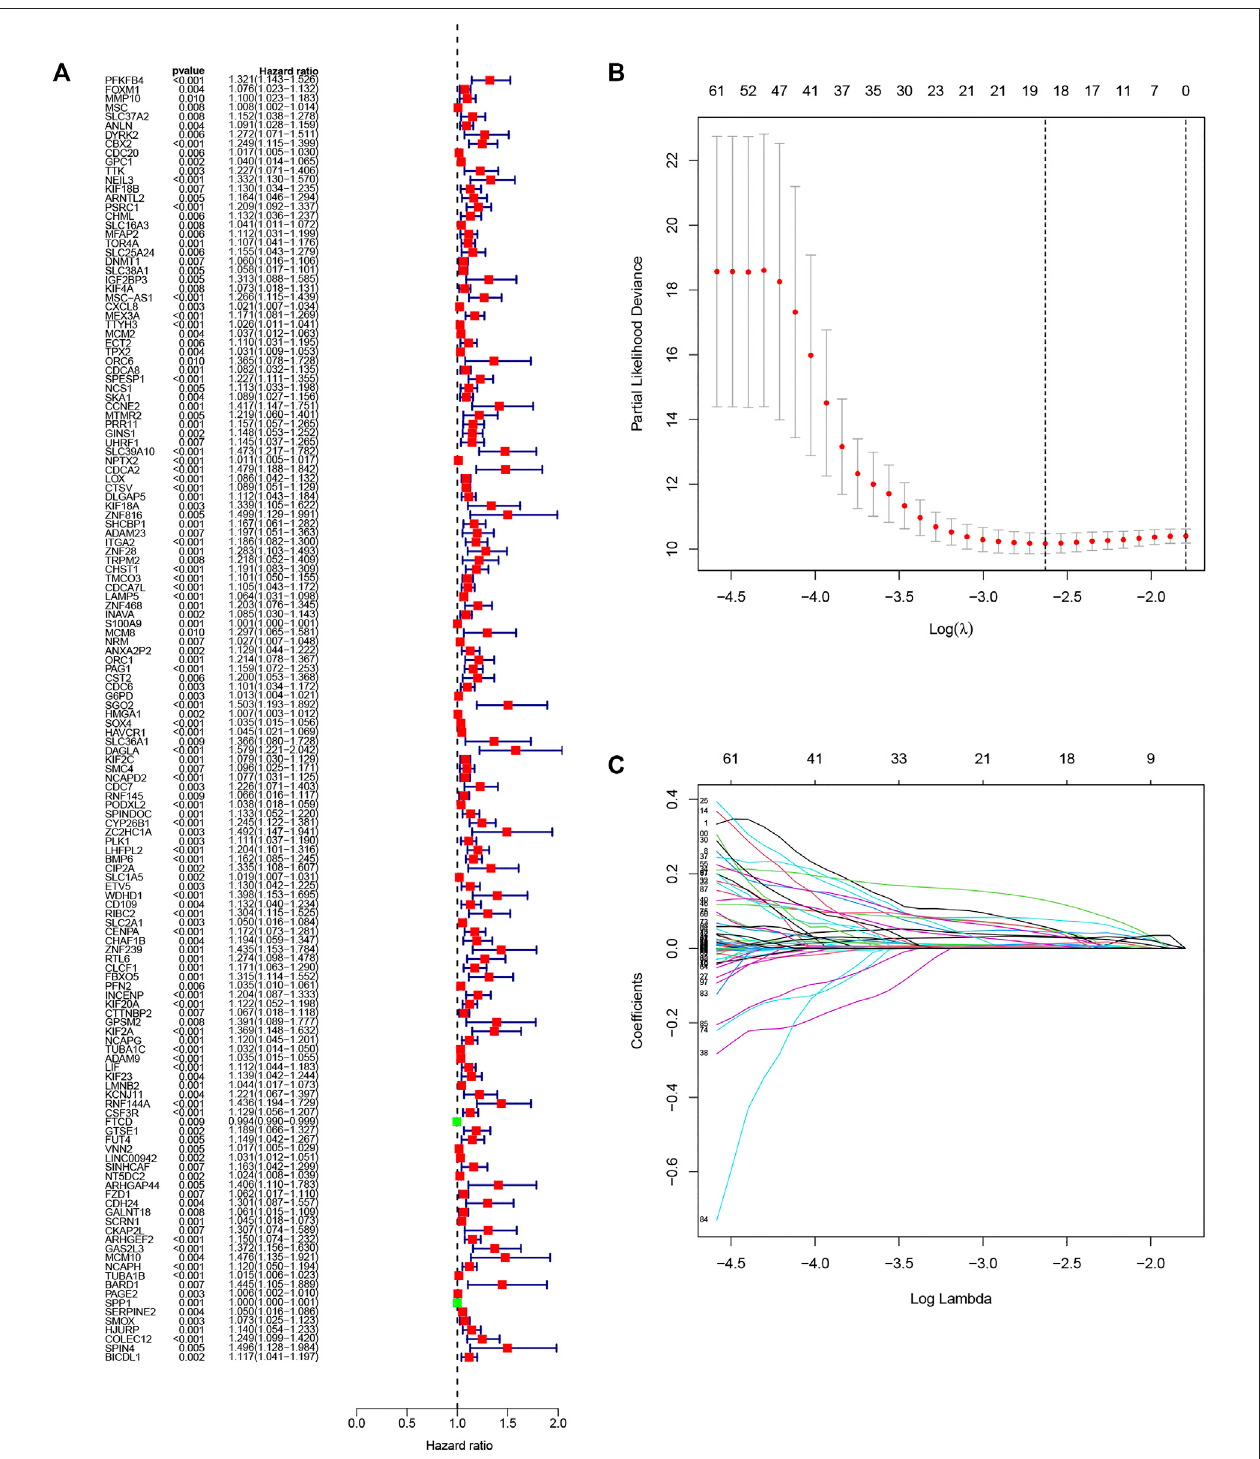
FIGURE 3 | Selection of genes in the training set for inclusion in the signature. (A) Forest plot of univariate results showing 143 OS-related DENRGs ( p < 0.05). (B) LASSO was used to screen OS-related DENRGs. (C) LASSO coef fi cient pro fi les determined by the optimal lambda.